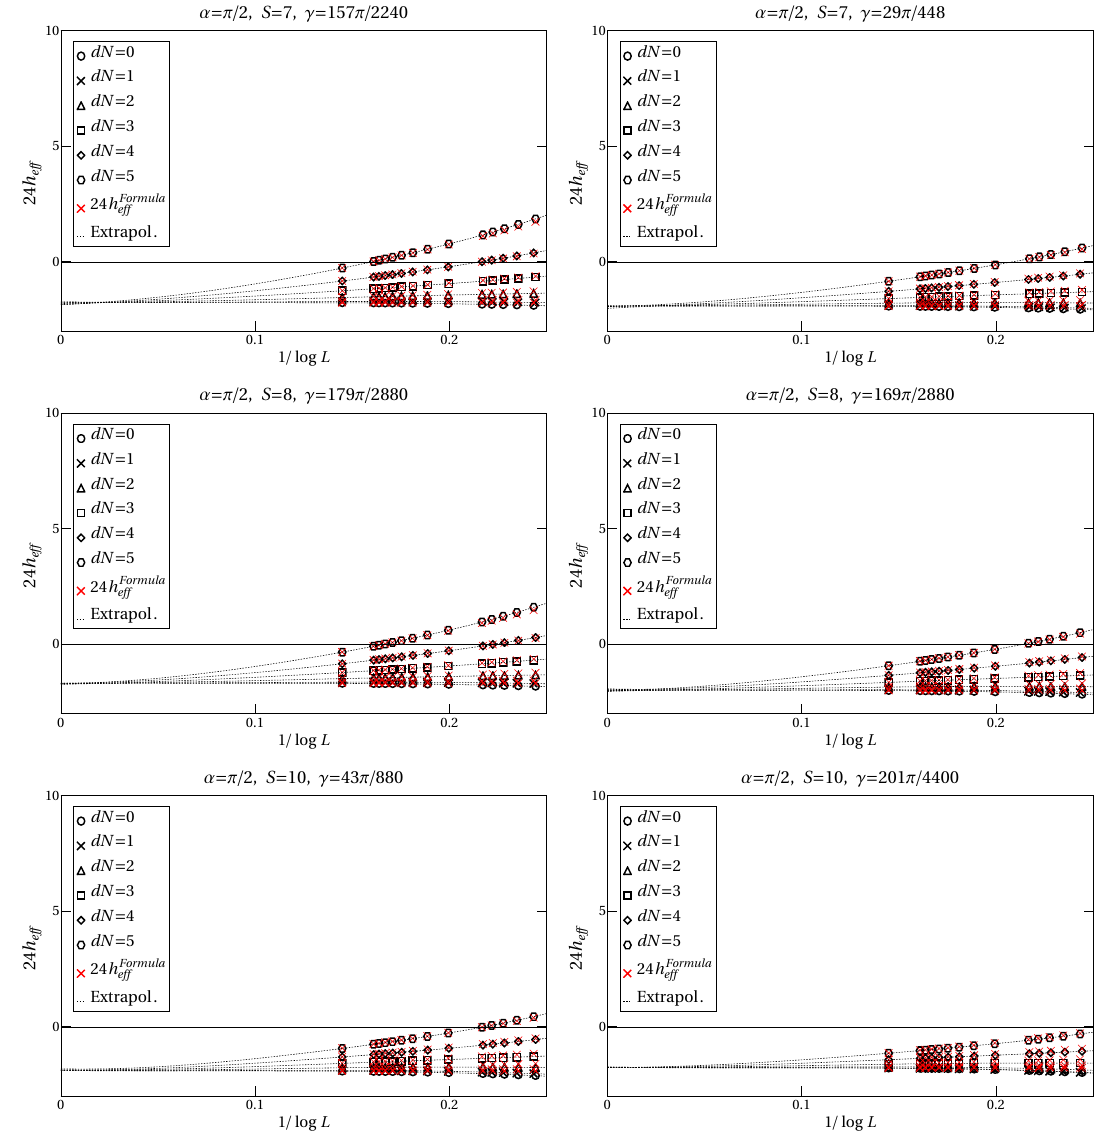
Figure 9 . Similar as figure 8, but for anisotropies where the ground state is found in the sectors S = 7 , 8 , 10